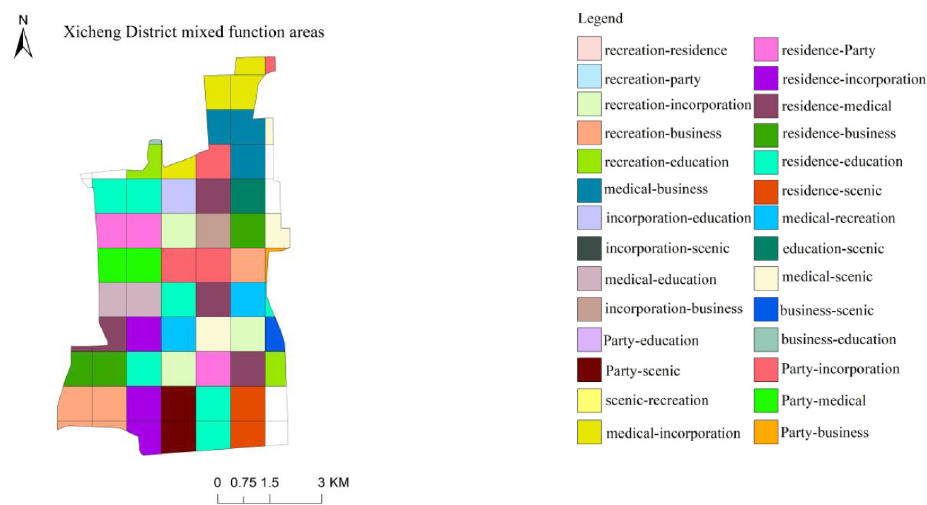
Table 2. Mixed-functional areas in the Xicheng District, Beijing.